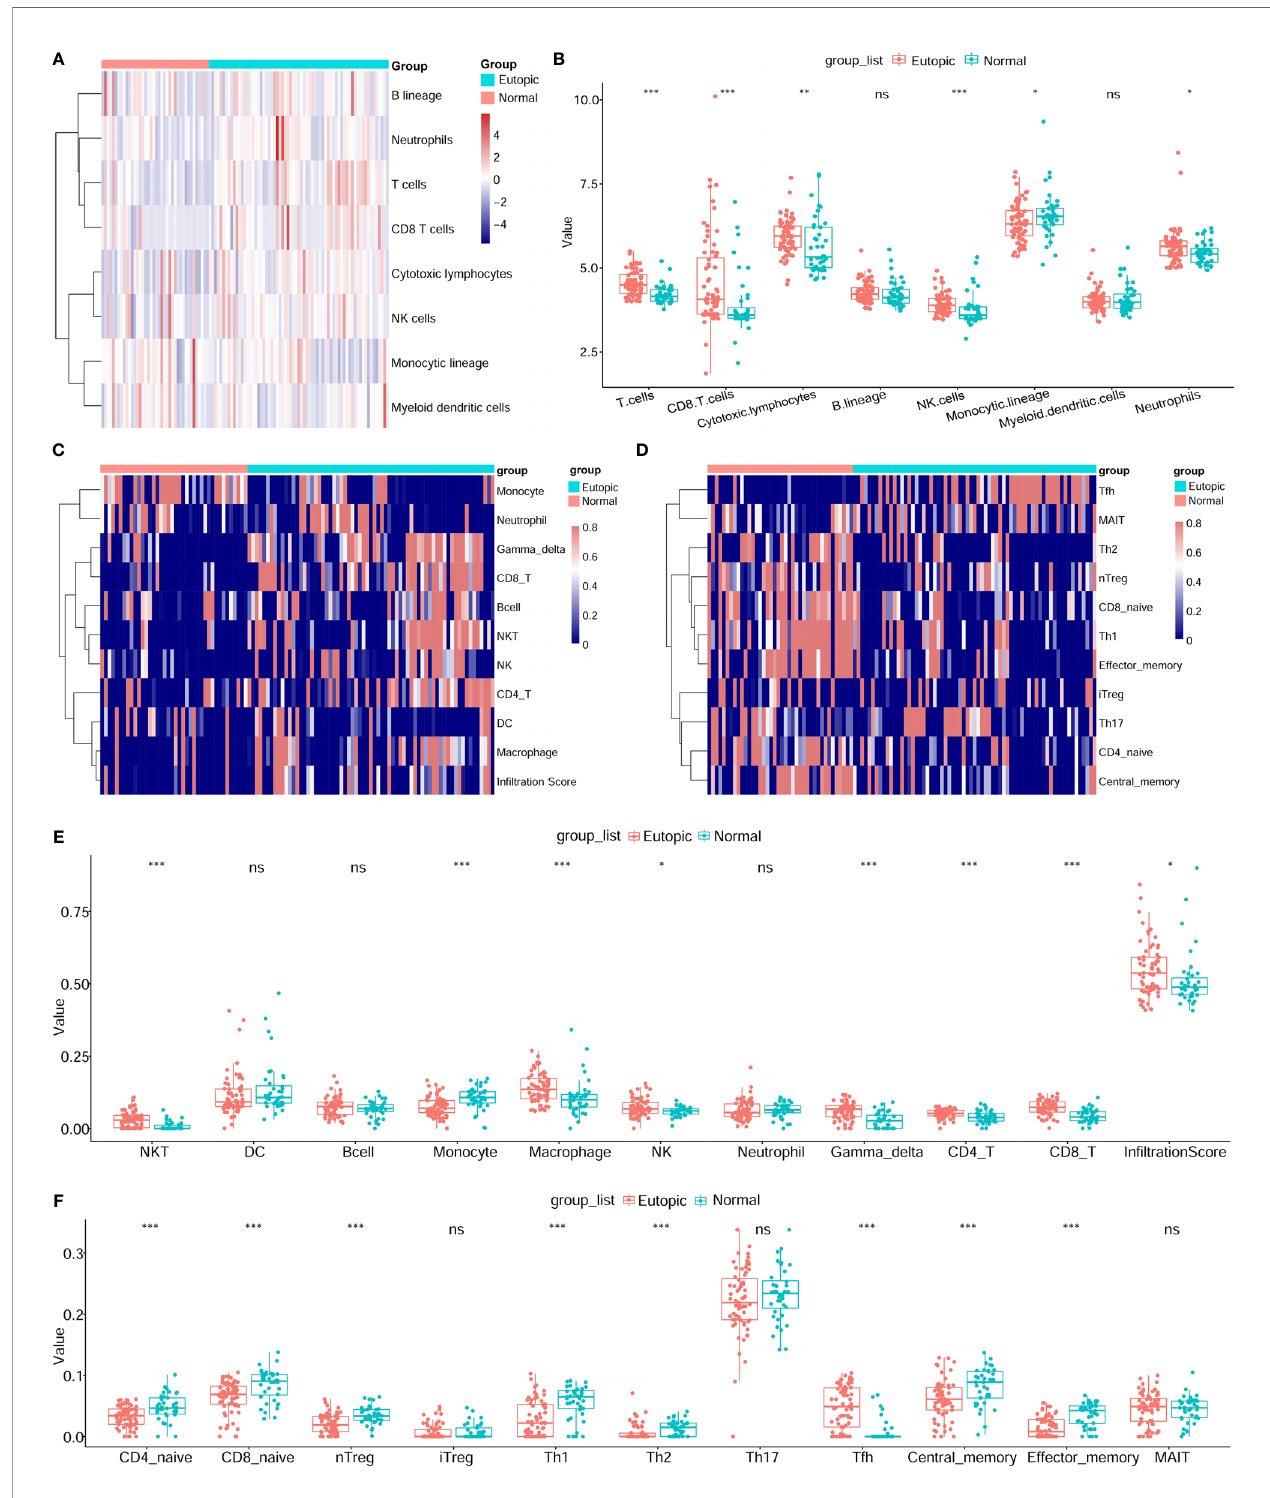
FIGURE 3 | Estimation of in fi ltrating immune cells by the MCP-counter and immuCellAI methods. (A, B) The results of the MCP-counter method: the heatmap shows the absolute abundances of eight immune cell subsets (A) and boxplots comparing the abundances of eight immune cell subsets between normal and endometriosis samples. (C – F) The immuCellAI results: the heatmap shows the proportions of 10 major types of immune cells and the in fi ltration scores (C) and boxplots comparing the proportions of 10 immune cell subsets between normal and endometriosis samples. The subsets of CD4+ T cells and CD8+ T cells are also shown by the heatmap (D) and boxplots (F) . Data were assessed by the Wilcoxon rank-sum test. *P < 0.05, **P < 0.01, and ***P < 0.001. ns, no signi fi